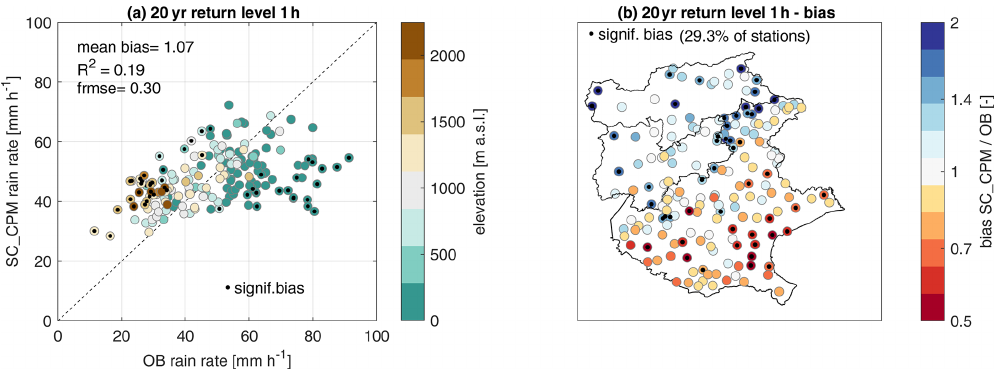
Figure 5. Bias assessment of 20-year return level at 1h duration. (a) Rainfall rate for 20-year return level and 1h duration for station-colocated CPM (SC_CPM) versus observed values (OB); the color of the point indicates the elevation of the station; and mean bias, coefficient of determination ( R 2 ), and fractional mean squared error (frmse) are also shown. (b) Maps of SC_CPM/OB relative bias for the 1h duration 20-year return level. In all panels, significant differences at the 5% level are indicated by a black dot, and their proportion is reported as the percentage of significant cases on the total number of